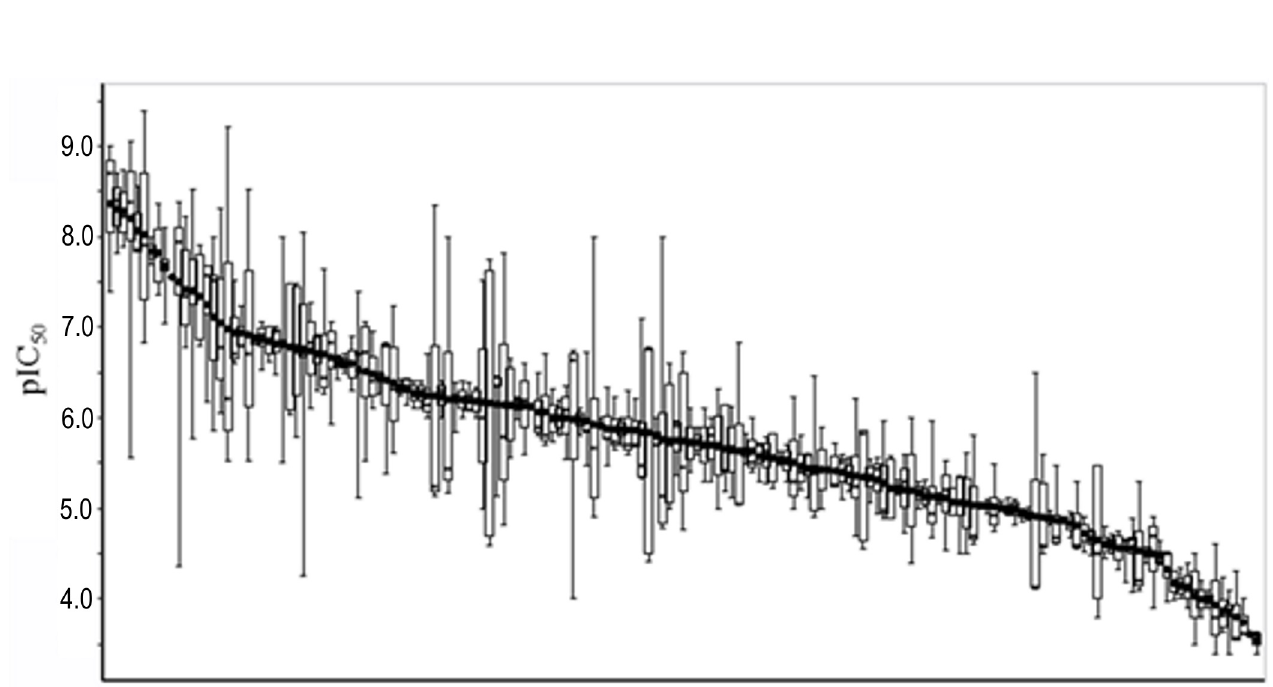
Fig 4. Box plot showing the distribution of IC 50 values of 263 compounds with more than three reported IC 50 values. The compounds were sorted by mean values.